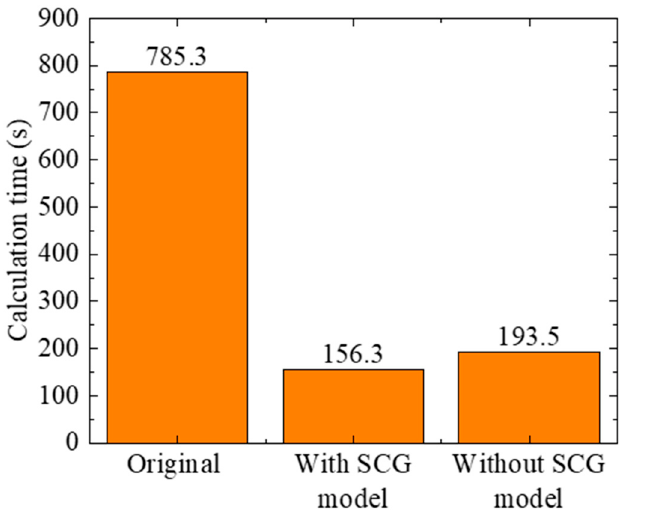
Figure 8. Comparison of calculation time for representing the behaviors of the original particles and the CG particles with and without the SCG model for 0.1 s.